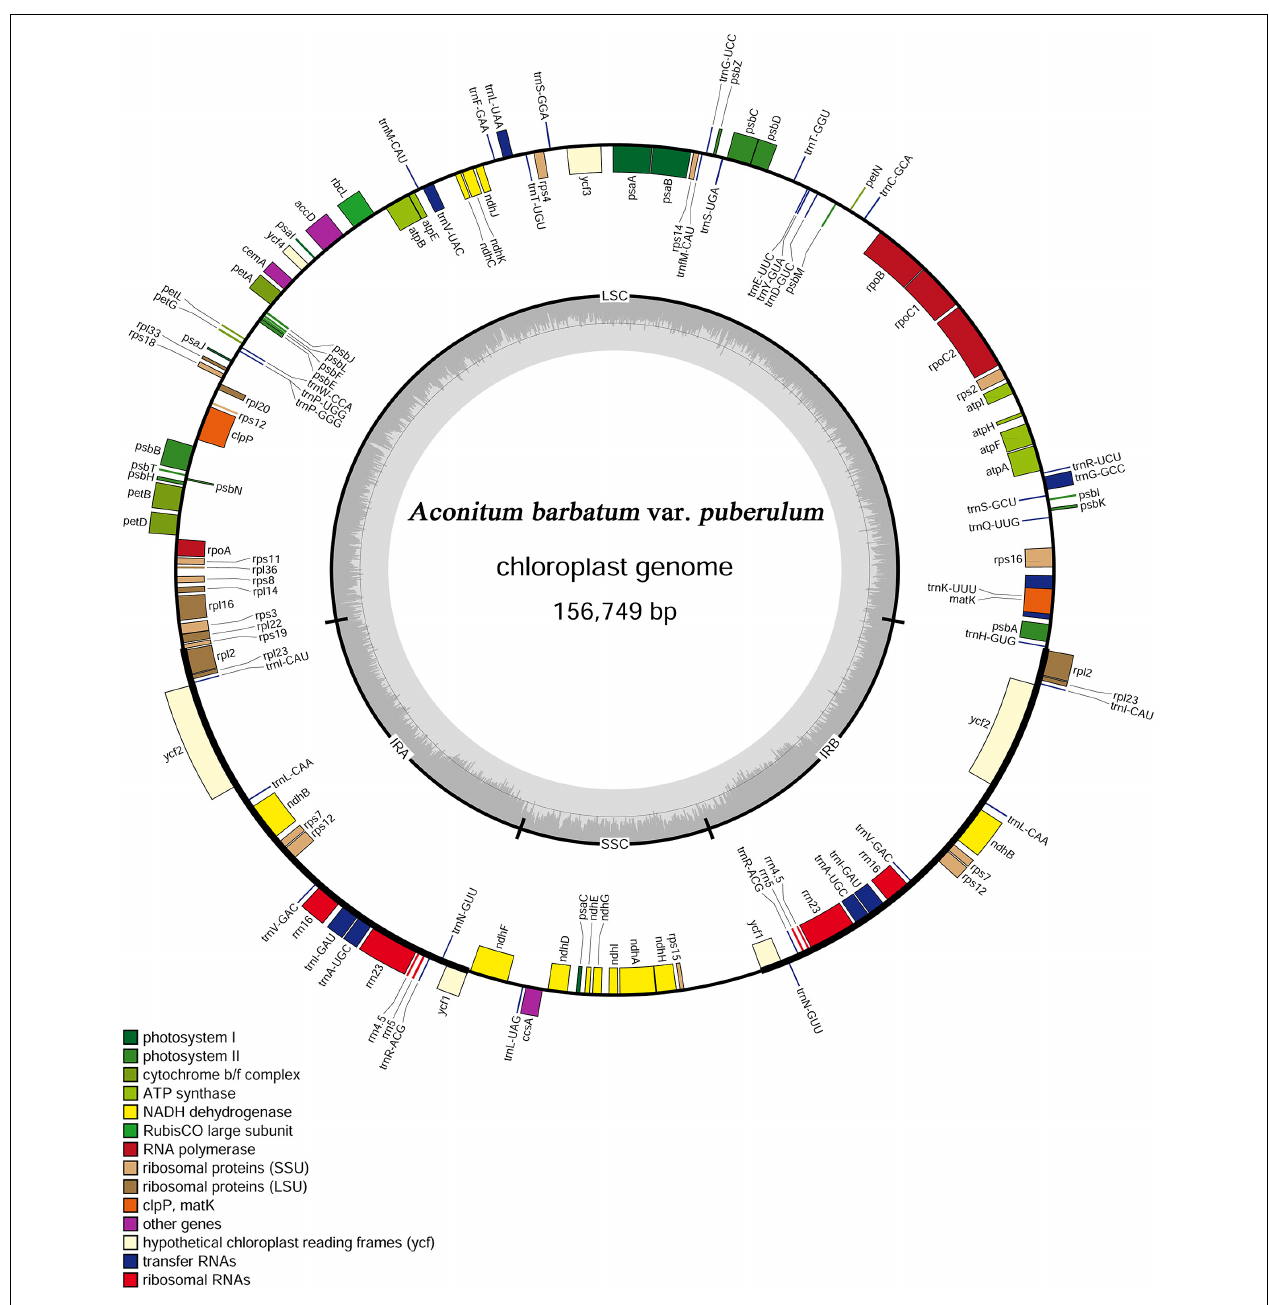
FIGURE 1 | Gene map of the Aconitum barbatum var. puberulum chloroplast